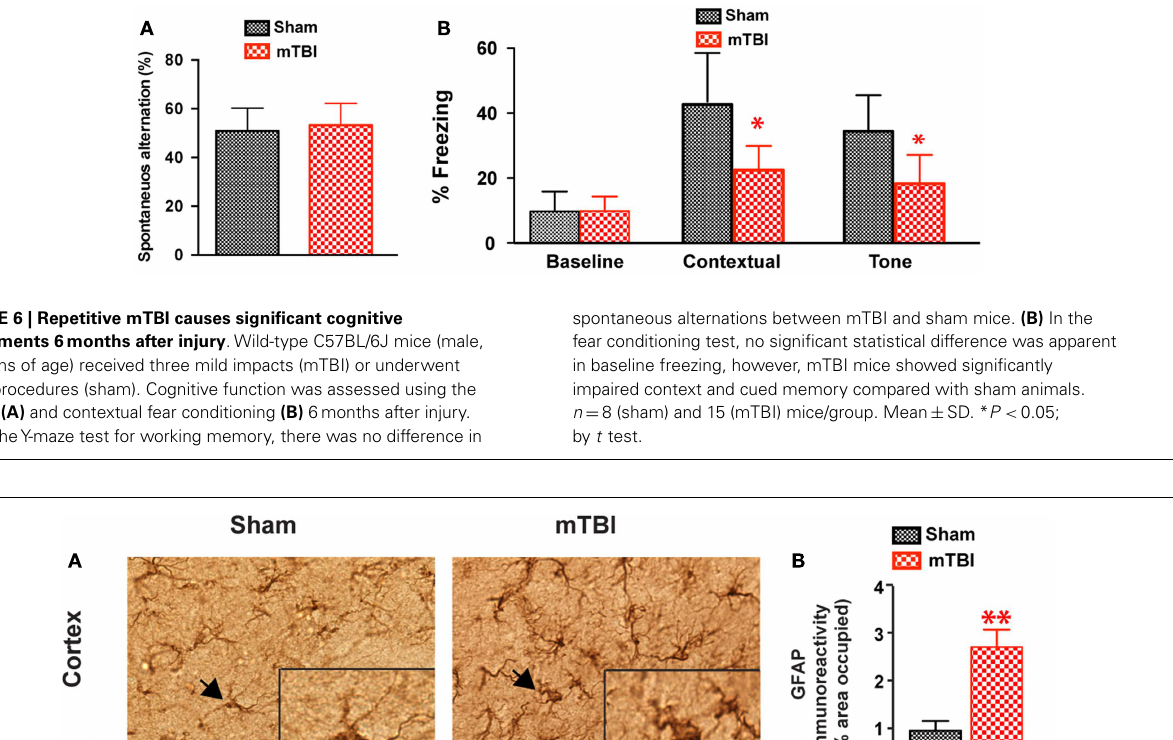
FIGURE 7 | Significant astrogliosis after repetitive mTBI .Wild-type C57BL/6J mice (male, 3months of age) received three mild impacts (mTBI) or underwent sham procedures (sham). Mice were sacrificed 6months later and brains were fixed for immunohistochemistry with an antibody against GFAP. Representative images were taken from cortex (A) ,